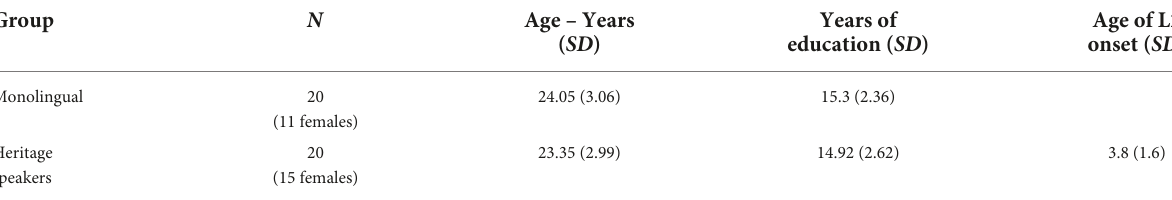
TABLE 3 Participant information.